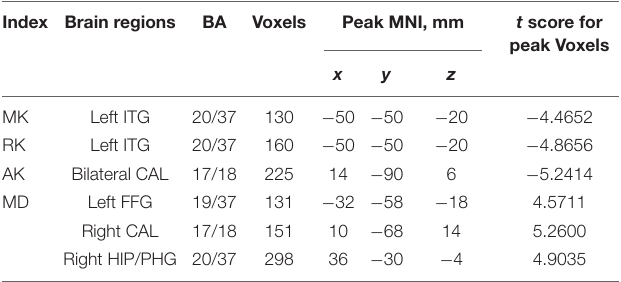
TABLE 2 | Regions showing significant differences in DKI metrics between the NMOSD-ON and NCs groups. Index Brain regions